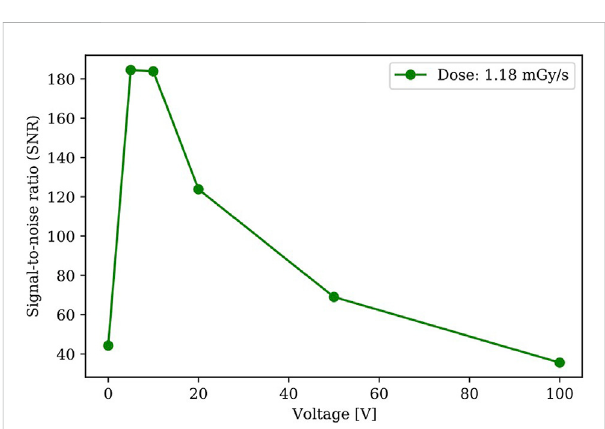
FIGURE 12 Signal-to-noise ratio at different applied bias voltages of a Ag/ Cs 3 Bi 2 Br 9 /Ag